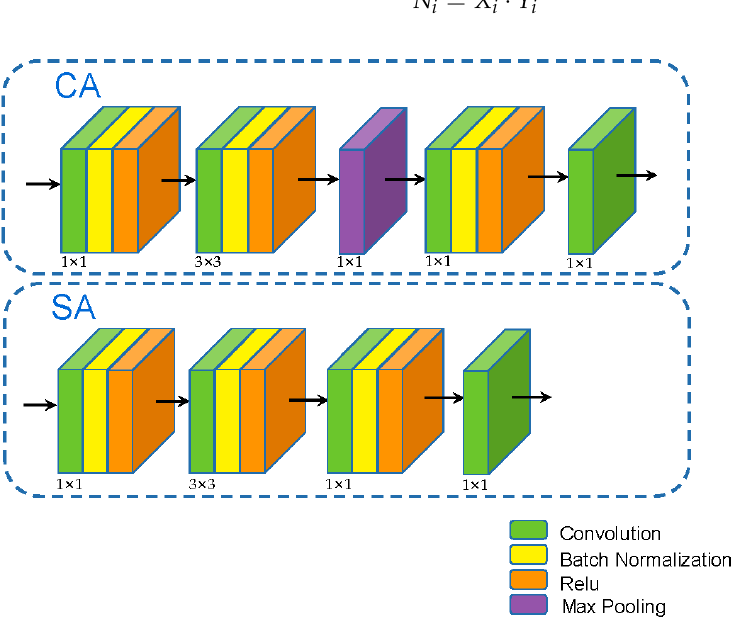
Figure 5. The generation mechanism of spatial attention weight (SA weight) and channel attention weight (CA weight) [36] in Adaptive Multi-Scale Module. The number marked below the picture is the size of the convolution